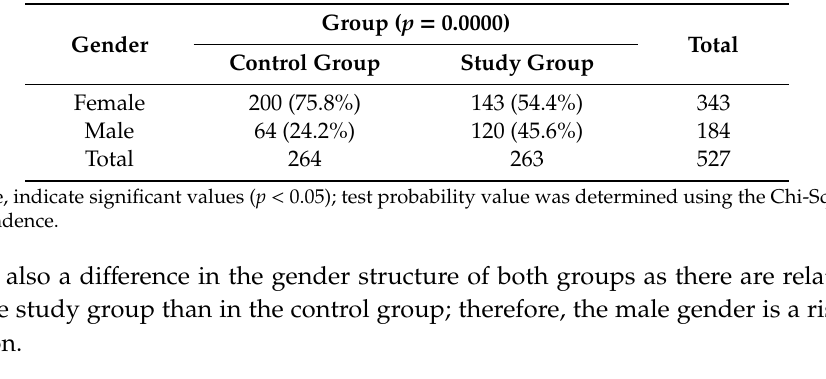
Table 2. Characteristics of the studied and control groups by gender. Group ( p = 0.0000) Gender Control Group Study Group Female 200 (75.8%) Total 264 263 527